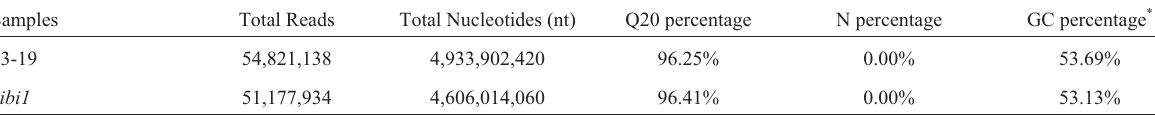
Table 1 - Read number and statistics based on the RNA-Seq data in the wild type and mutant.